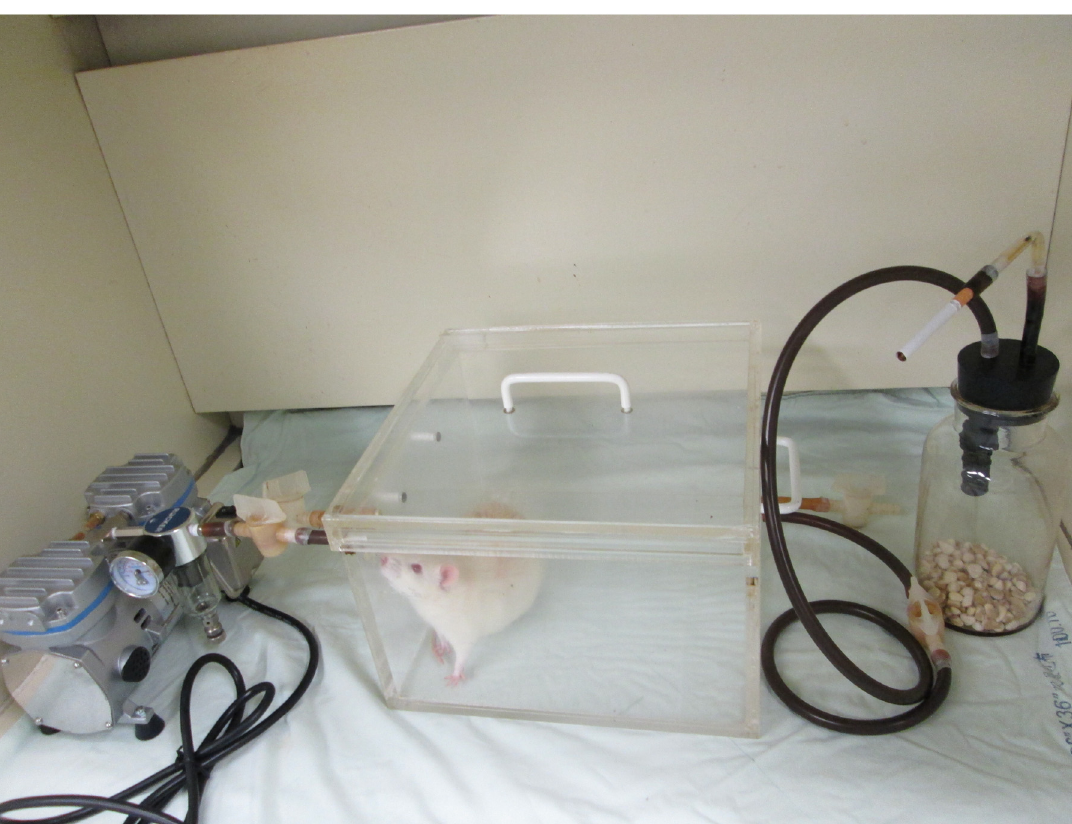
Fig 1. Smoke exposure equipment. The rat was housed in an enclosed plastic cage (28x28x19 cm) and subjected to a constant influx of cigarette smoke using a small air pump. One lighted cigarette was placed into an inverted tube connected to a peristaltic pump communicating with the cage.